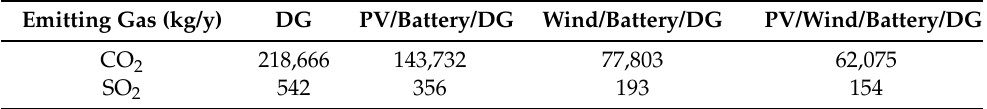
Table 9. Comparison of emission analysis.